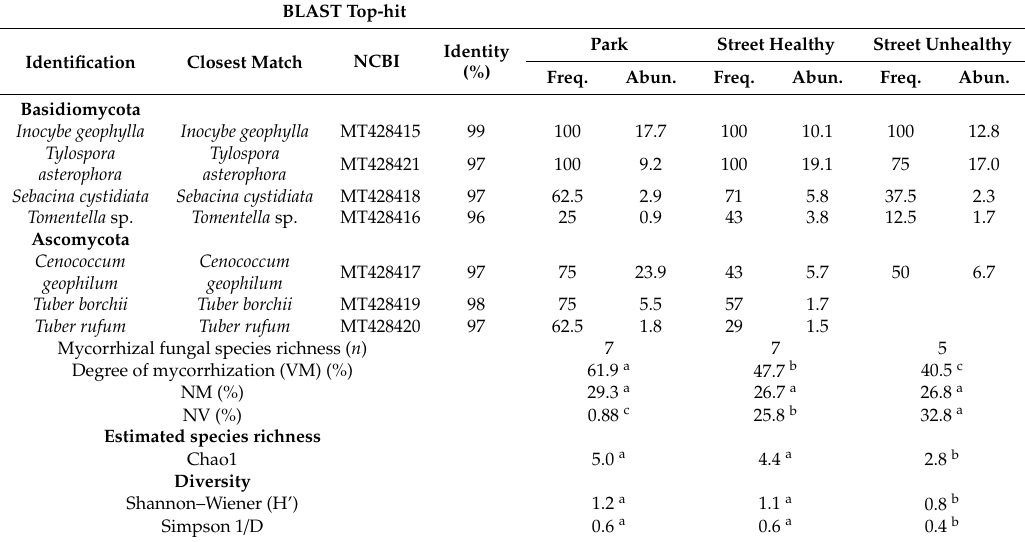
Table 2. Estimated species richness, diversity, and occurrence of ectomycorrhizal fungal taxa associated with the roots of Crimean linden.